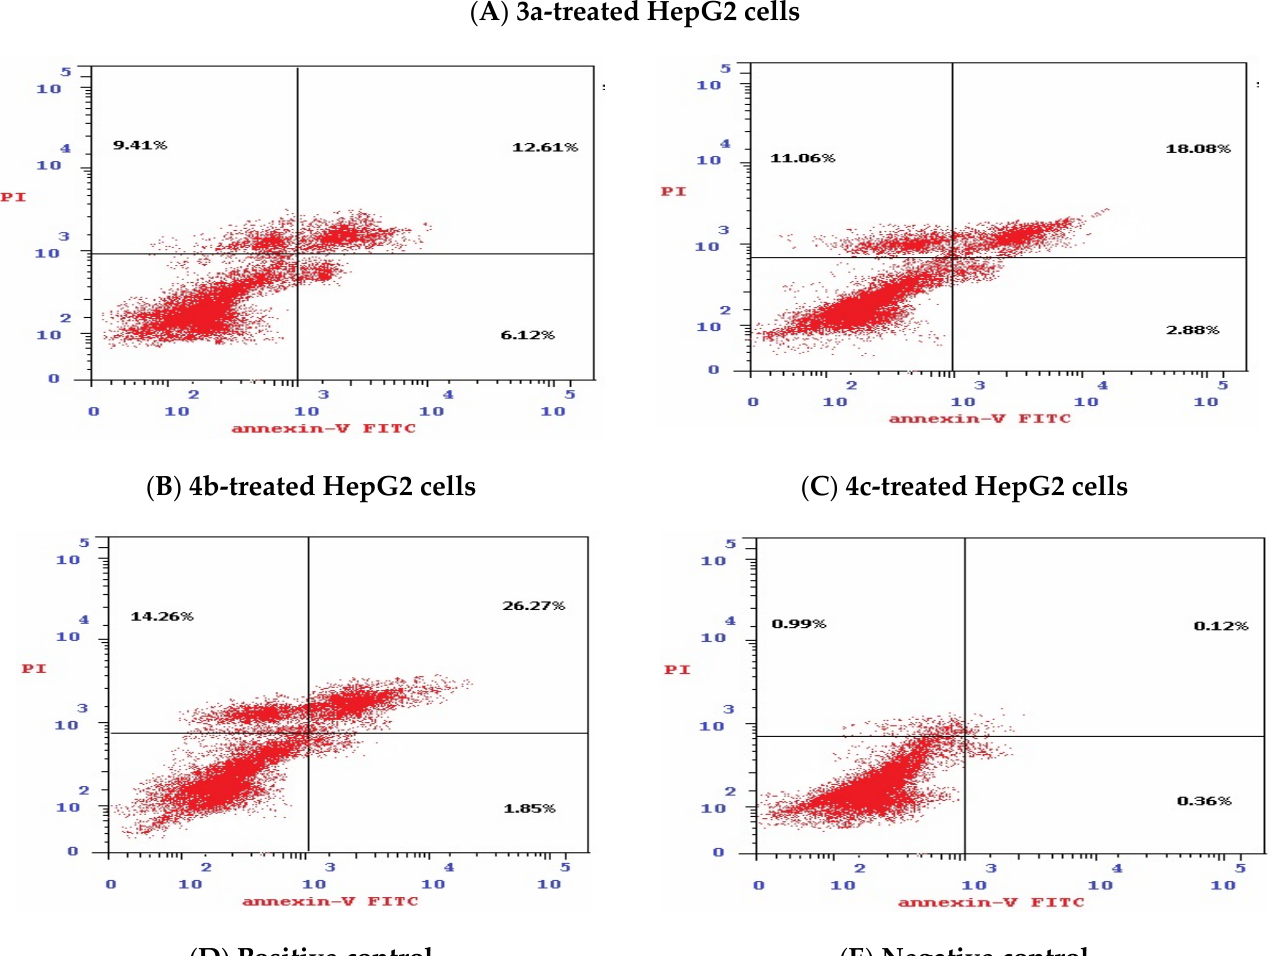
Figure 4. Apoptosis analysis by flow cytometry using the Annexin V/PI double staining method (( A ) compound 3a -treated HepG2 cells, ( B ) compound 4b -treated HepG2 cells, ( C ) compound 4c - treated HepG2 cells, ( D ) positive control; Dox-treated HepG2 cells, and ( E ) negative control; non- treated HepG2 cells). Apoptosis analysis depends on the quantitation of DNA content after PI staining, being stoichiometric, i.e., cells in the S phase will have more DNA than cells in the G1 phase and will take up proportionally more dye and will fluoresce more brightly. Cells in the G2 phase will be approximately twice as bright as cells in the G1 phase.